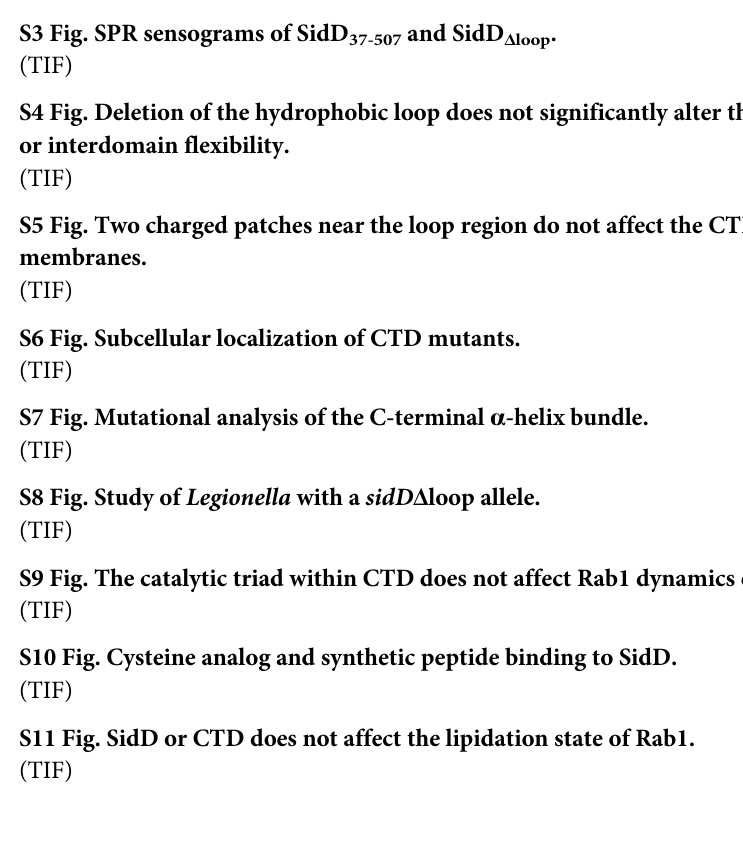
S1 Fig. Zn 2+ identification. S2 Fig. Lipid-protein overlay assay with SidD . 37-507 S3 Fig. SPR sensograms of SidD and SidD . 37-507 Δ loop S4 Fig. Deletion of the hydrophobic loop does not significantly alter the structure of SidD or interdomain flexibility. S5 Fig. Two charged patches near the loop region do not affect the CTD selectivity for membranes. S6 Fig. Subcellular localization of CTD mutants. S7 Fig. Mutational analysis of the C-terminal α -helix bundle. S8 Fig. Study of Legionella with a sidD Δ loop allele. S9 Fig. The catalytic triad within CTD does not affect Rab1 dynamics on LCVs. S10 Fig. Cysteine analog and synthetic peptide binding to SidD. S11 Fig. SidD or CTD does not affect the lipidation state of